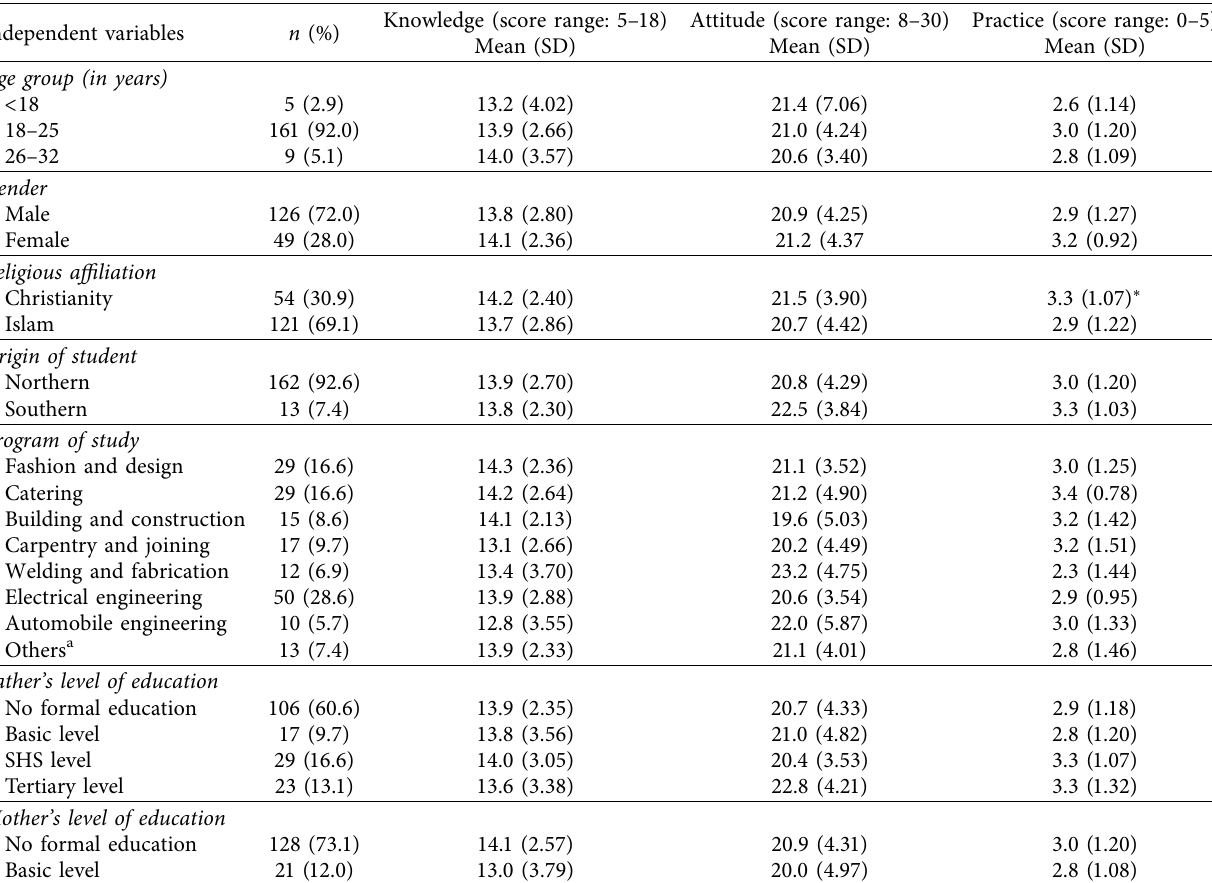
Table 3: Differences in the level of knowledge, attitudes, and practices towards COVID-19 according to students’ characteristics. Independent